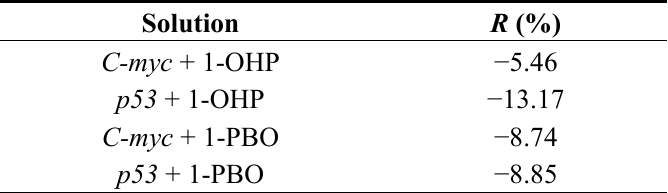
Table 3. Changes in quenching extents of EB-DNA system in the absence and presence of pyrene